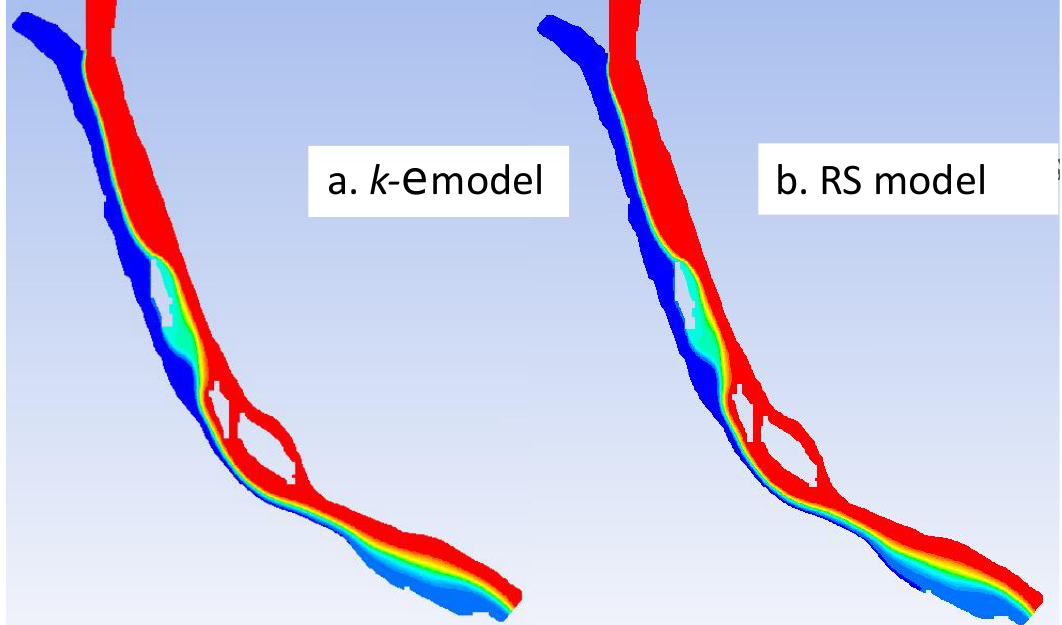
Figure 11. Comparison of the standard k-ε model ( a ) and the Reynolds Stress model ( b ) predictions of mixing for a Kama discharge of 1480 m 3 ·s −1 and a Vishera discharge of 2940 m 3 ·s −1 .